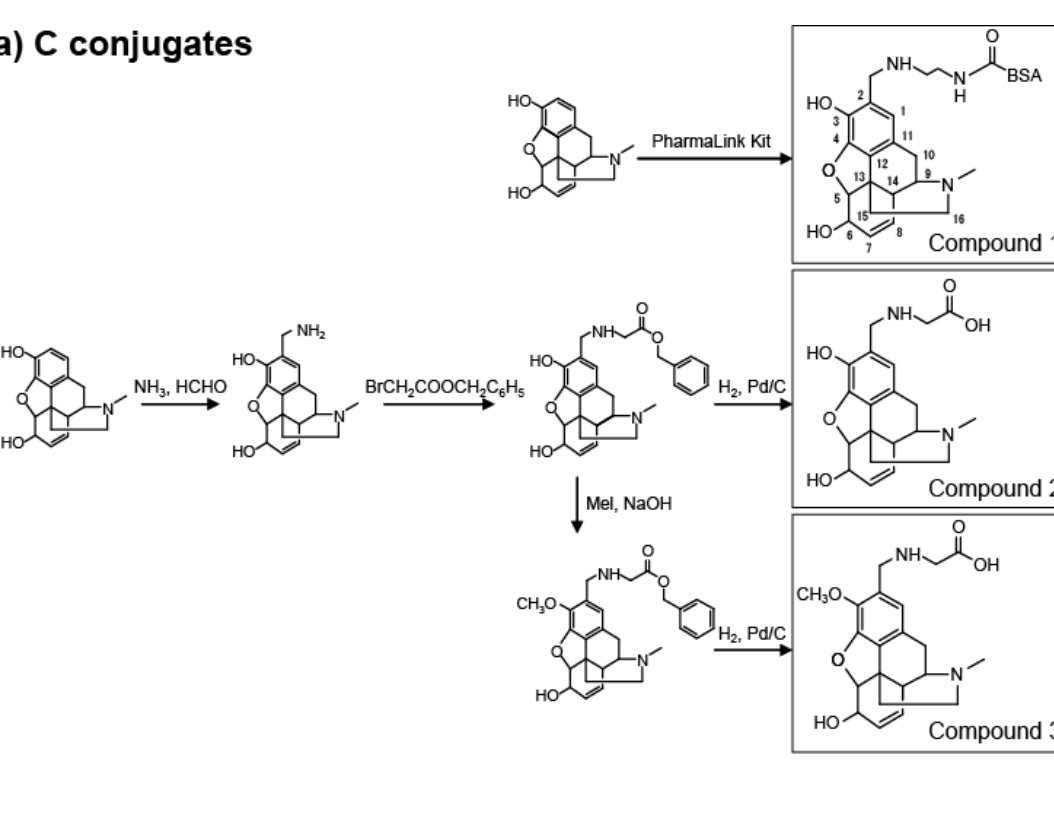
Figure 1. Synthesis of protein (BSA or Tg) conjugated with narcotics. ( a ) C conjugate derivatives; ( b ) N conjugate derivatives; ( c ) Conjugation of compounds 2–6 with proteins; ( d ) Summary of antigens used in this study. Parentheses indicate the experimental